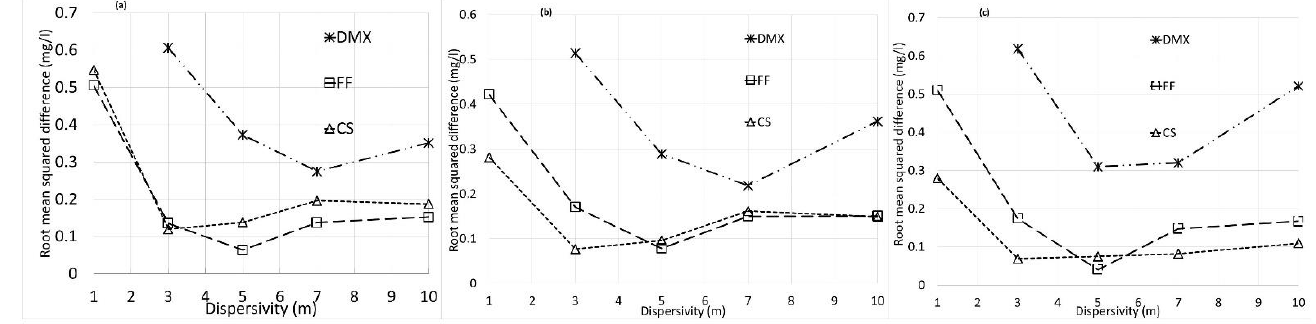
Figure 7. Tracer concentration relative difference to the MODFLOW/MT3DMS tracer concentration at the different layers in Problem 3: ( a ) top; ( b ) middle; and ( c ) bottom layer.